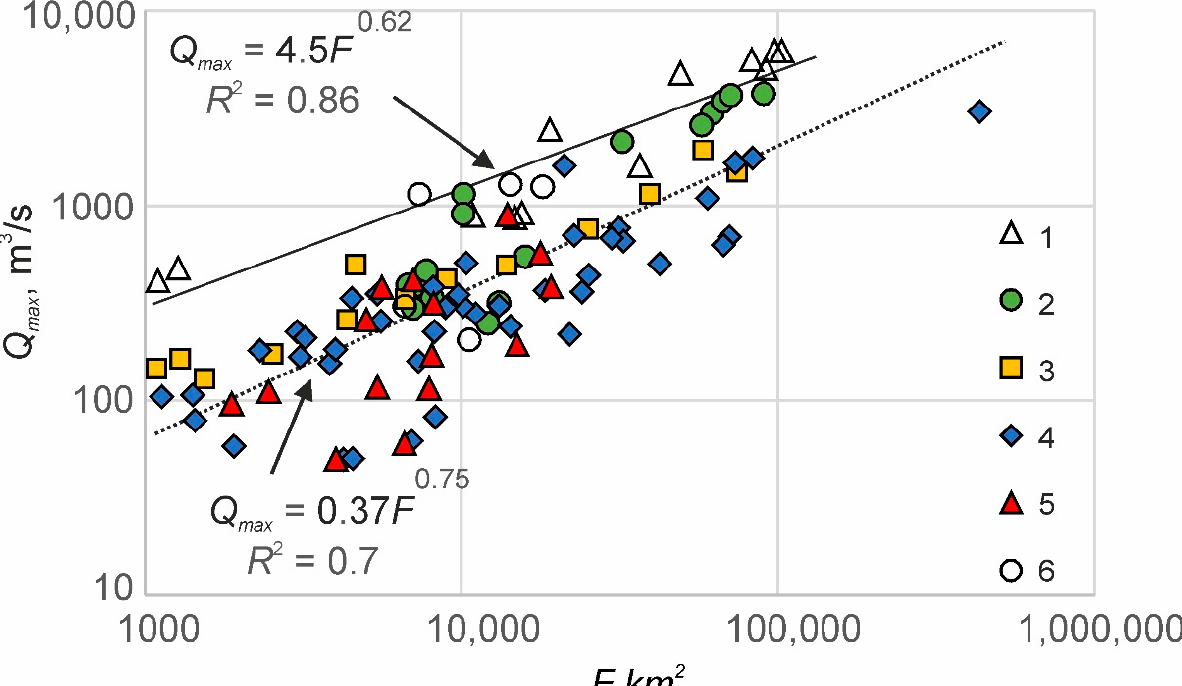
Figure 10. Regional relationships between mean flood discharge Q max and contributing basin area F for the modern rivers of West Siberia. Landscapes: 1—tundra, 2—sparse forest (forest–tundra), 3—northern and middle taiga with permafrost, 4—middle and southern taiga, permafrost-free; 5—forest–steppe and steppe, 6—Altai piedmont.